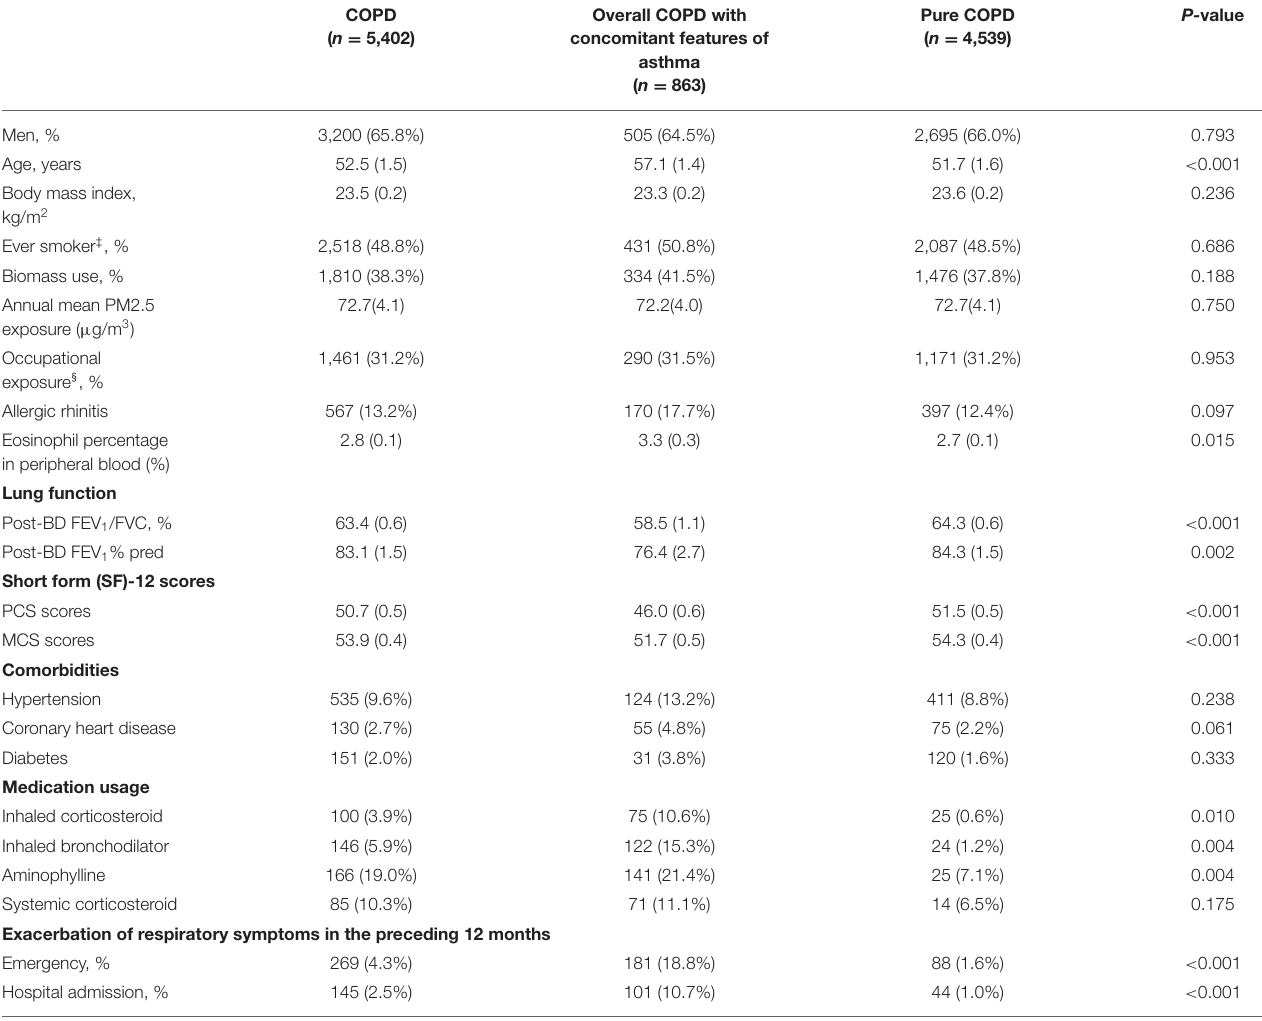
TABLE 1 | Risk factors and clinical characteristics of COPD with concomitant features of asthma and pure COPD.